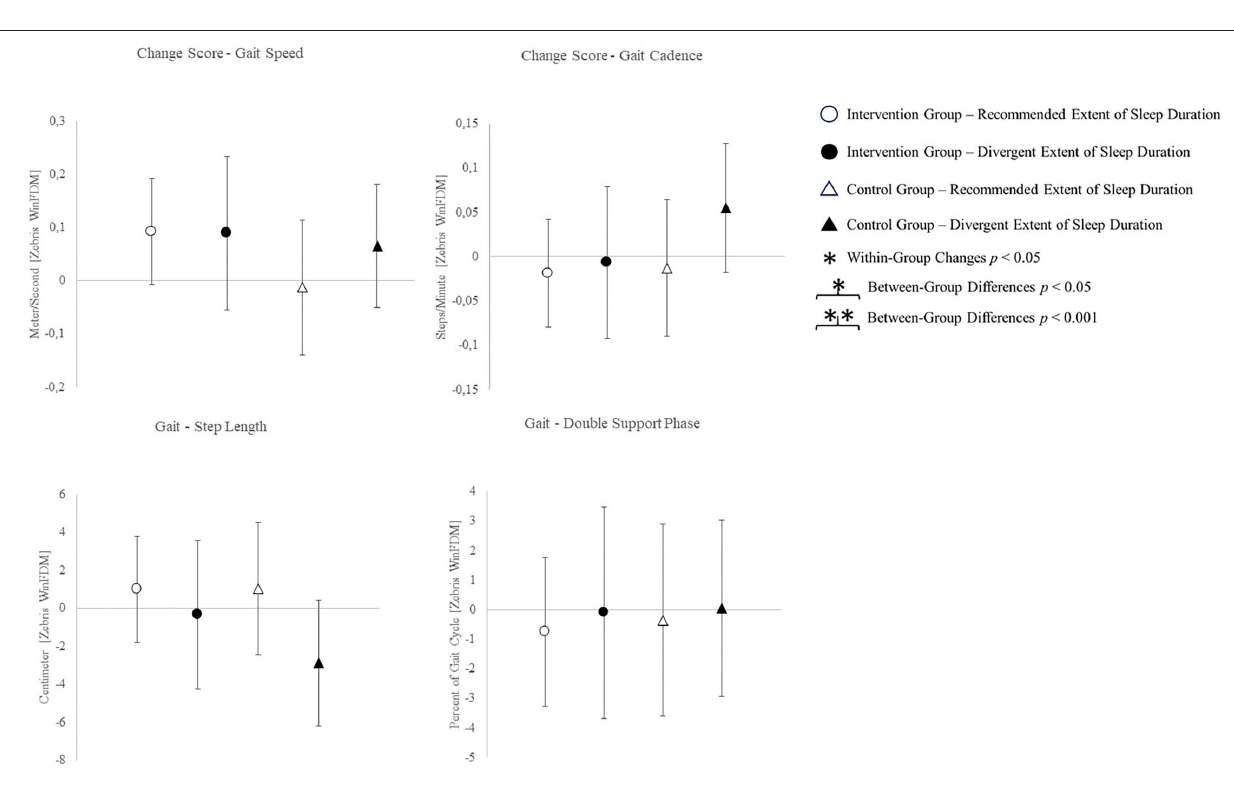
FIGURE 4 | Change scores of the outcomes of gait analyses. Means and CIs are